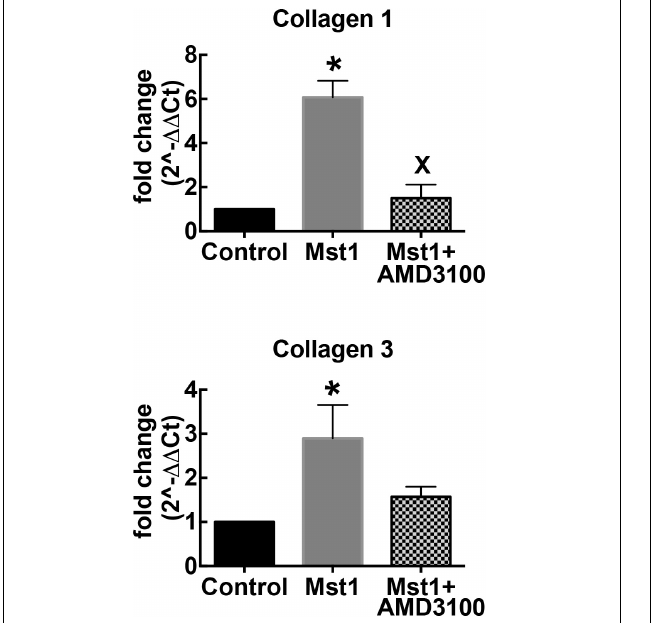
FIGURE 2 | Bar graphs representing relative collagen I and collagen III mRNA expression. ∗ p < 0.05 vs. control; x p < 0.05 vs. Mst-1.